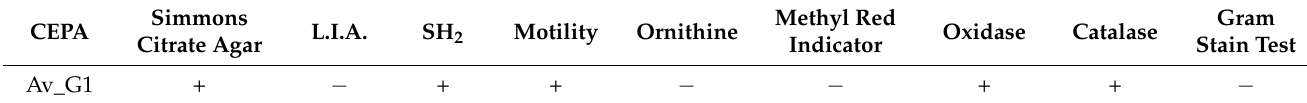
Table 2. Biochemical tests for identification of Citrobacter sp.